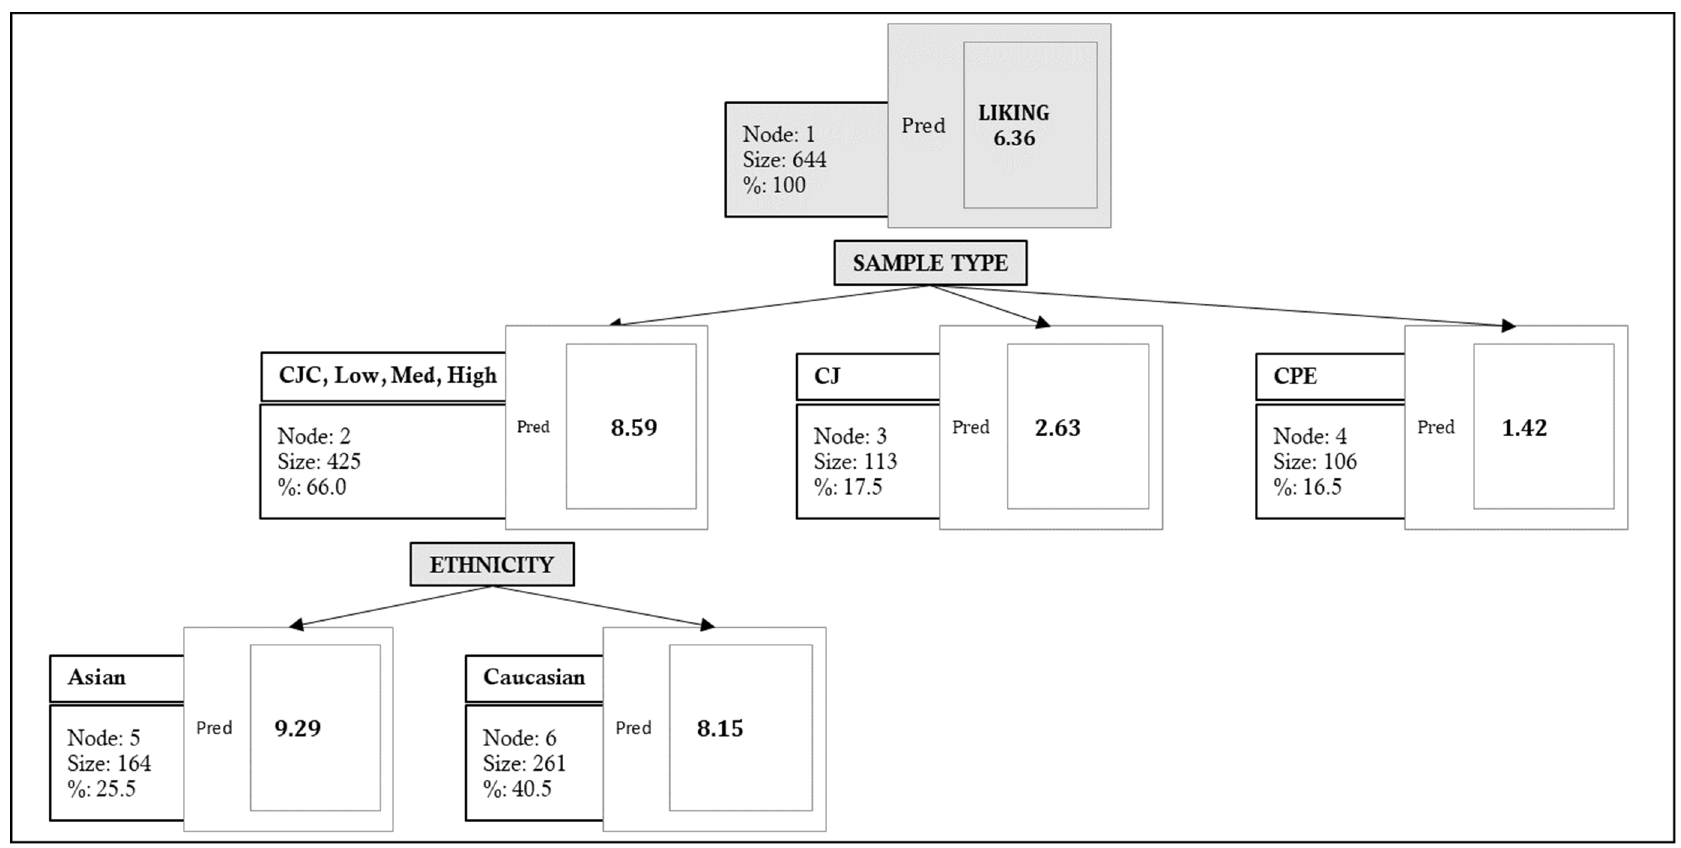
Figure 3. ( 3a ): Regression tree for sweetness intensity ratings. Node refers to a split based on a significant test ( p < 0.05). Size refers to number of subjects in a given split while % refers to the corresponding percentage of the total subjects in a given split. ‘Pred’ shows predicted values of intensity ratings on the 15 ‐ cm line scale. ( 3b ): Regression tree for sourness intensity ratings. ( 3c ): Regression tree for bitterness intensity ratings. ( 3d ): Regression tree for astringency intensity ratings. ( 3e ): Regression tree for thickness intensity ratings. ( 3f ): Regression tree for cranberry flavor intensity ratings. ( 3g ): Regression tree for overall flavor intensity ratings. ( 3h ): Regression tree for overall liking ratings.